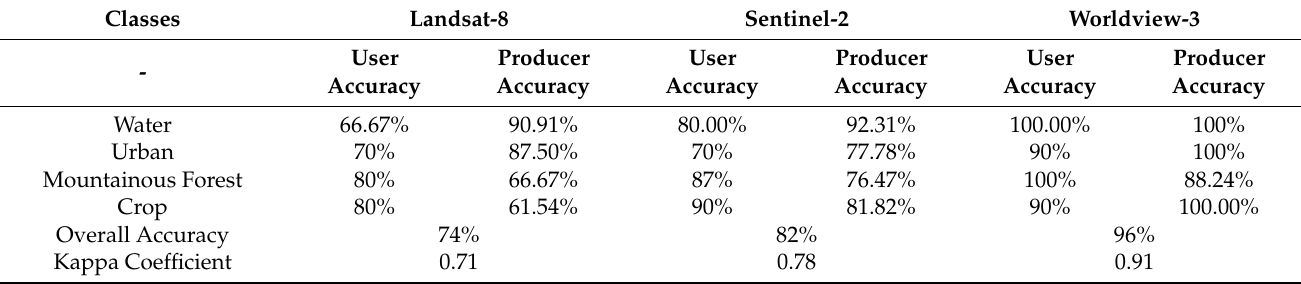
Table 2. The accuracy assessment approach between observed and land cover